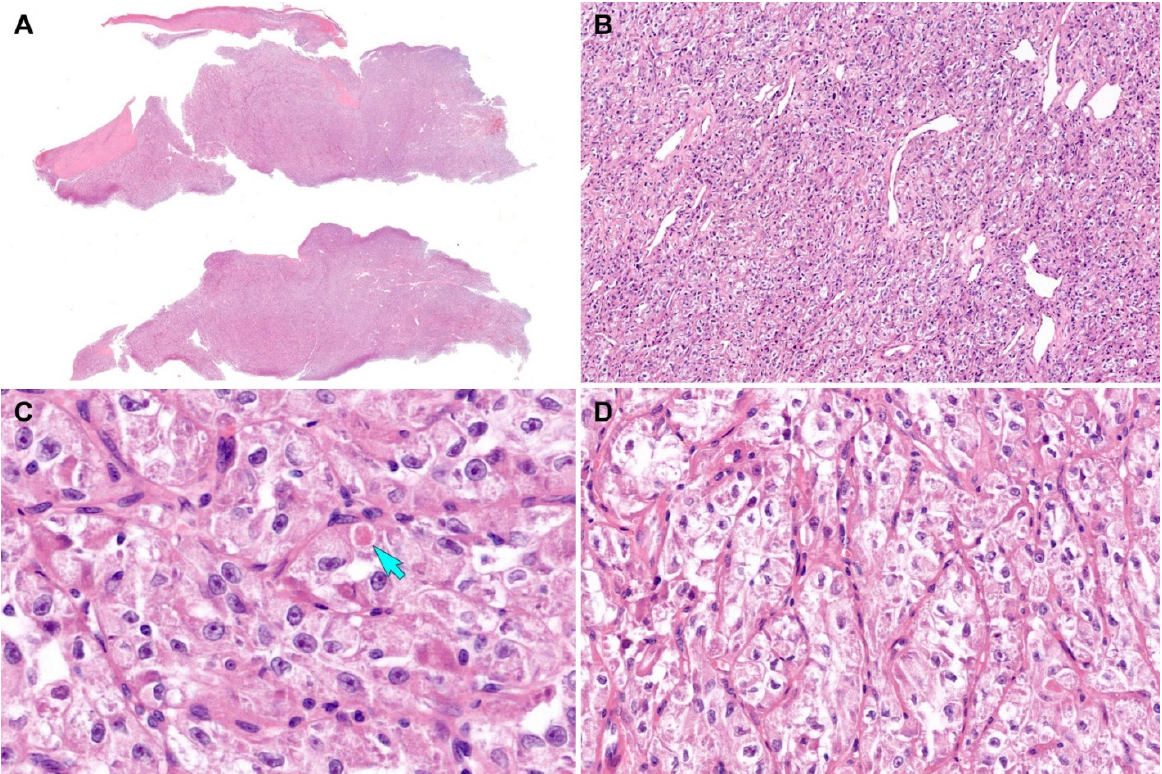
Figure 5. Histological findings (case 2). ( A ) Scanning-power magnification of the mass excision specimen reveals lobulated tumor tissue. ( B ) Low-power magnification reveals a diffuse growth pattern without nested architecture. Mildly dilated sinusoidal vascular channels are noted. ( C ) High-power magnification depicts eosinophilic intracytoplasmic globules (blue arrow) and pleomorphic nuclei with conspicuous nucleoli. ( D ) The discohesive tumor cells are arranged in a pseudoalveolar pattern in some areas. Original magnification: A, 10×; B, 40×; C, 400×; D, 200×.